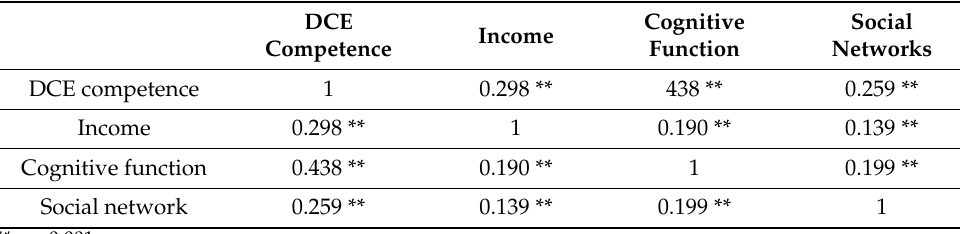
Table 5. Correlation of DCE competence with income, cognitive function, and social networks ( n = 10,073).